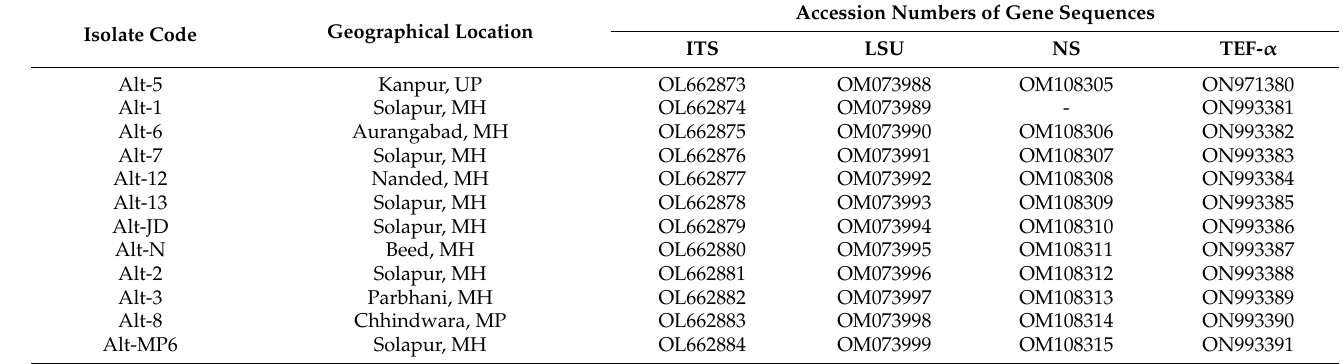
Table 2. Geographical origin and accession numbers of gene sequences of Alternaria isolates from pomegranate fruits characterized in the current study.